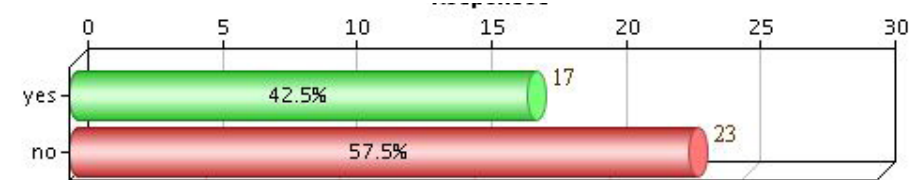
Figure 8 . Have you connected to any other MobiMOOC participants in order to collaborate on projects after the MobiMOOC? ( N =